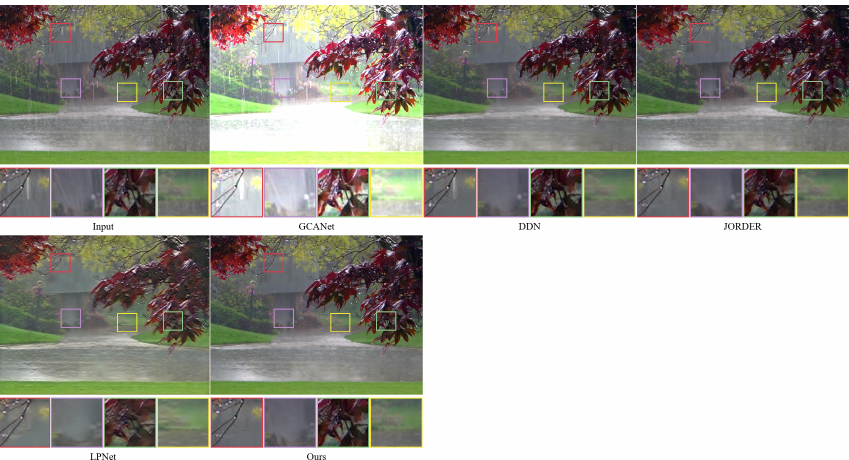
Figure 7. The performance of different methods on real world rainy dataset (Scene 1).